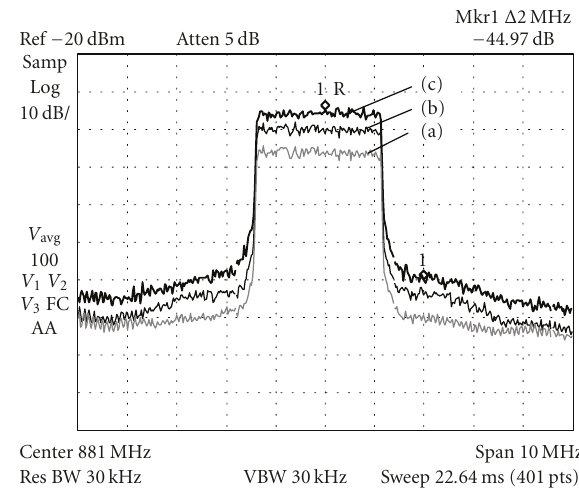
Figure 5: Power spectral density measurements at the output of the 45W base-station PA when (a) the input was backed-o ff , (b) a memory polynomial PD ( Q = 5, K = 5) was applied, and (c) both SLMTC ( M = 16, γ 0 = 7 . 5 dB) and the memory polynomial PD ( Q = 5, K = 5) were